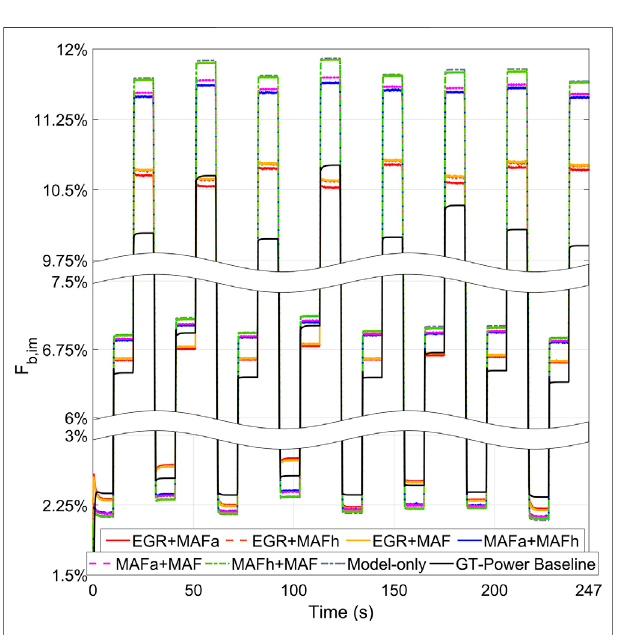
FIGURE 11 | Intake manifold burnt gas mass fraction estimation when using two sensors.